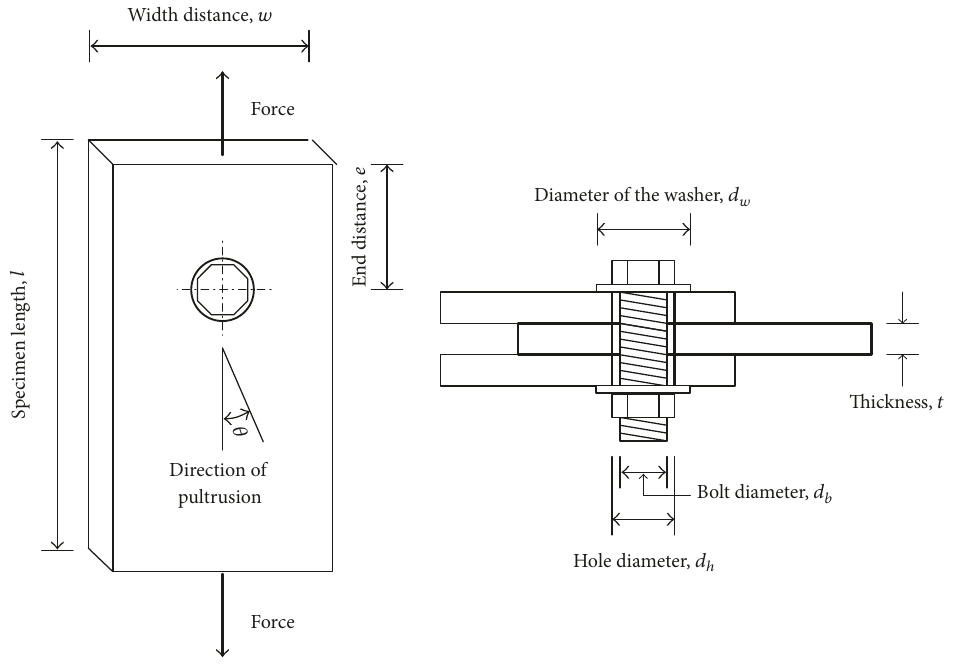
Figure 6: Geometric parameters for single-bolted connections.